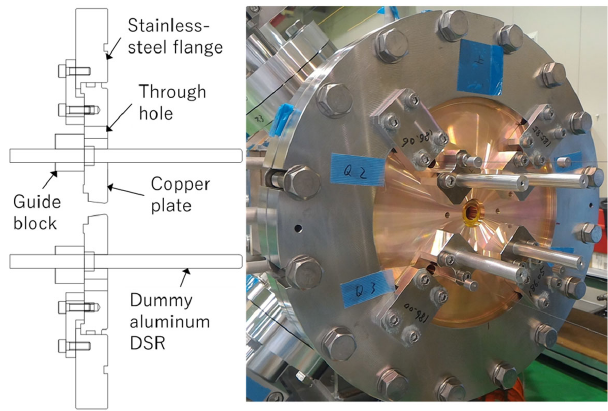
FIG. 9. Slug tuners with and without slits for vacuum pumping.